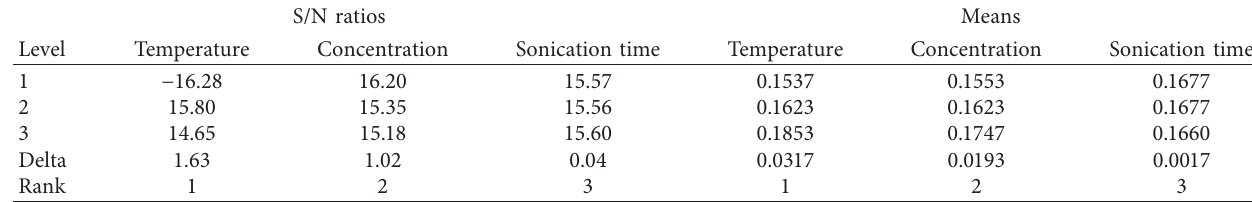
Table 7: S/N ratio and means for thermal conductivity (unmilled process).